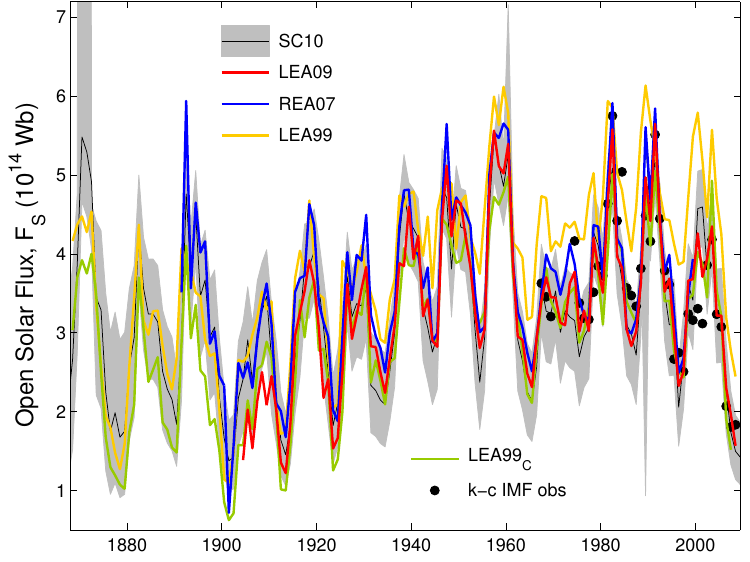
Figure 28: Reconstructions of annual means of the open solar flux 𝐹 𝑆 from geomagnetic activity data: LEA99 (orange), LEA09 (red), REA07 (blue), SC10 (thin black line with uncertainty shown by the sur- rounding grey area). See text for details. The variations are as they appear in the publications except that attributed to SC10, which is their variation in 𝐵 , converted to 𝐹 𝑆 using the polynomial fit shown in Figure 29. The green line (LEA99 𝐶 ) is derived from the LEA procedure, applied to the 𝑎𝑎 𝐶 index and to interplanetary data with the kinematic correction applied to | 𝐵 𝑟 | 1h . The solid circles are the values derived from interplanetary observations using the kinematic correction, described by Lockwood et al.